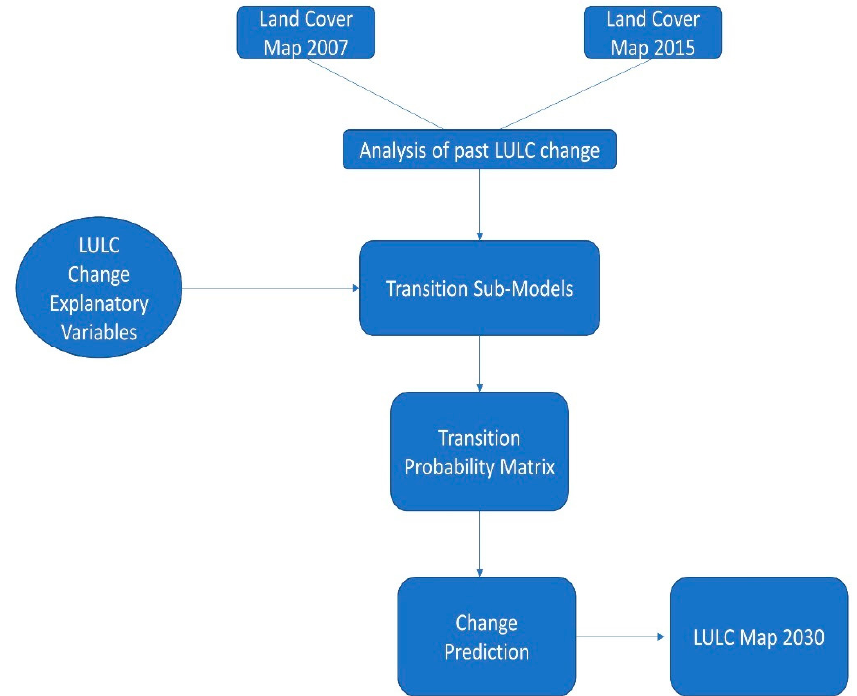
Figure 1. Flowchart showing different steps involved in land use and land cover (LULC) change modelling.